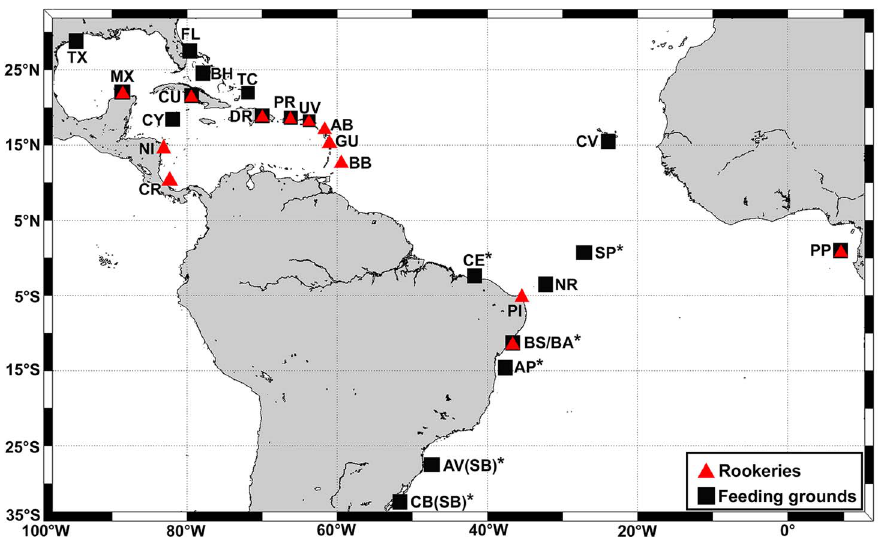
Figure 1. Locations of genetically described hawksbill populations in the Atlantic. Red triangles = rookeries, black squares = feeding grounds, *study areas described in this work. Rookeries: BS= Bahia/Sergipe, PI= Pipa, PP= Principe, BB= Barbados, GU= Guadeloupe, AB= Antigua & Barbuda, UV= U.S. Virgin Islands, PR= Puerto Rico, DR= Dominican Republic, CR= Costa Rica, NI= Nicaragua, CU= Cuba, MX= Mexico. Feeding grounds: SP= Sa˜o Pedro and Sa˜o Paulo, NR= Noronha/Rocas, CE= Ceara´ coast, BA= Bahia coast, AP= Abrolhos Park, SB= South Brazil, PP= Principe, CV= Cape Verde, UV= U.S. Virgin Islands, PR= Puerto Rico, DR= Dominican Republic, TC= Turks & Caicos, BH= Bahamas, FL= Florida, CU= Cuba, CY= Cayman Islands, MX= Mexico, TX=